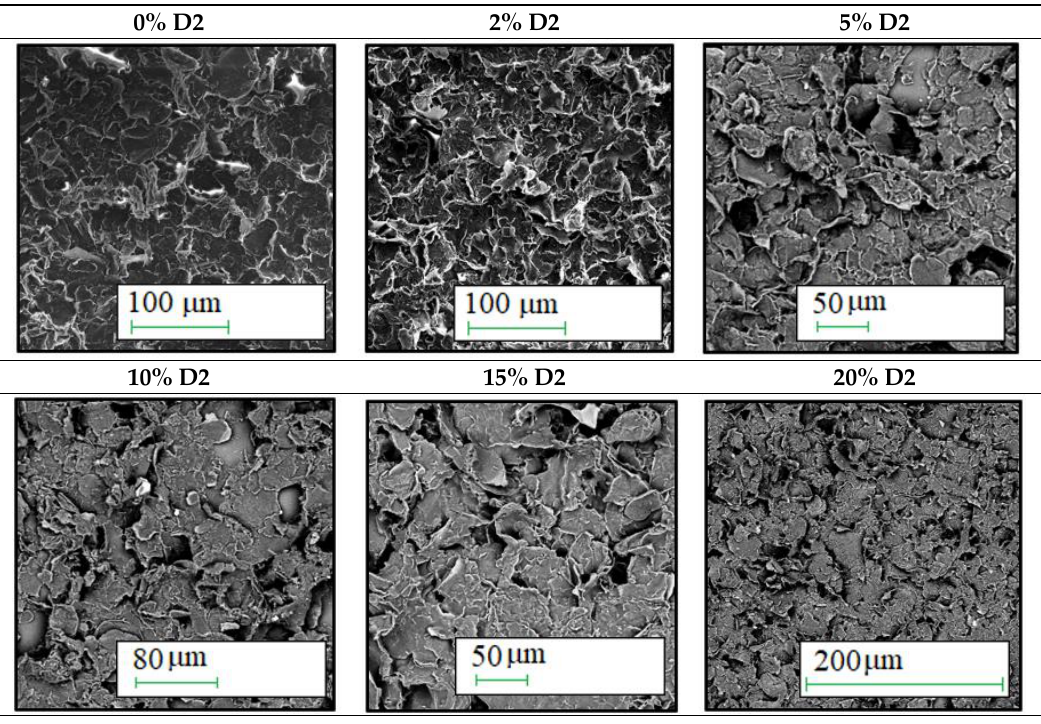
Figure 5. SEM photographs showing the quality of coatings made of the inks with various surfactant content.